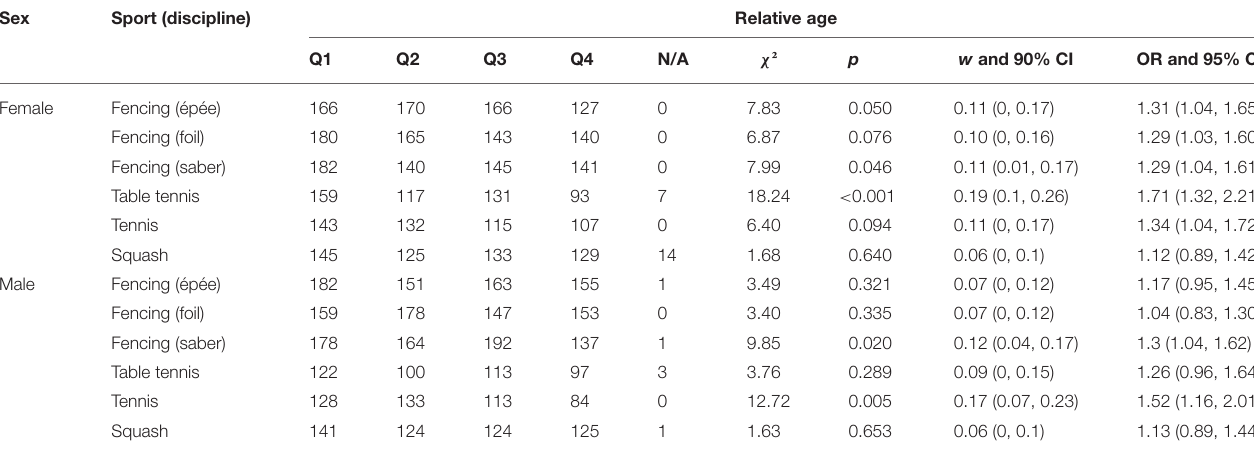
TABLE 3 | Absolute frequencies, results from chi-square goodness-of-fit tests, and odds ratios related to relative age in senior athletes (study 1). Sex Sport (discipline)